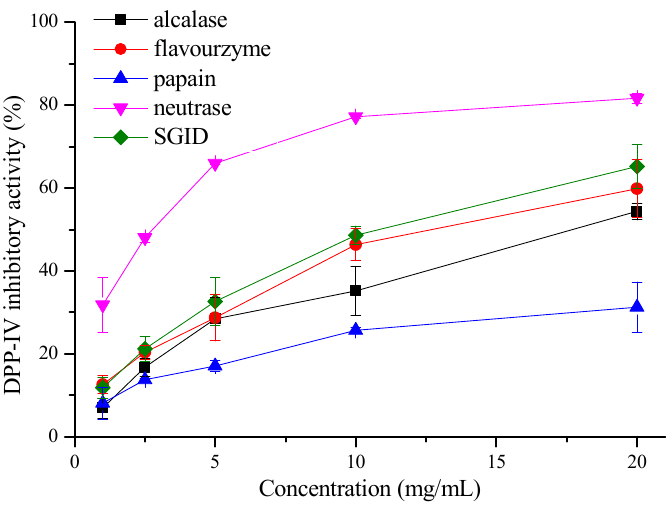
Figure 1. DPP-IV inhibitory activities of the oat protein hydrolysates by different enzymes.